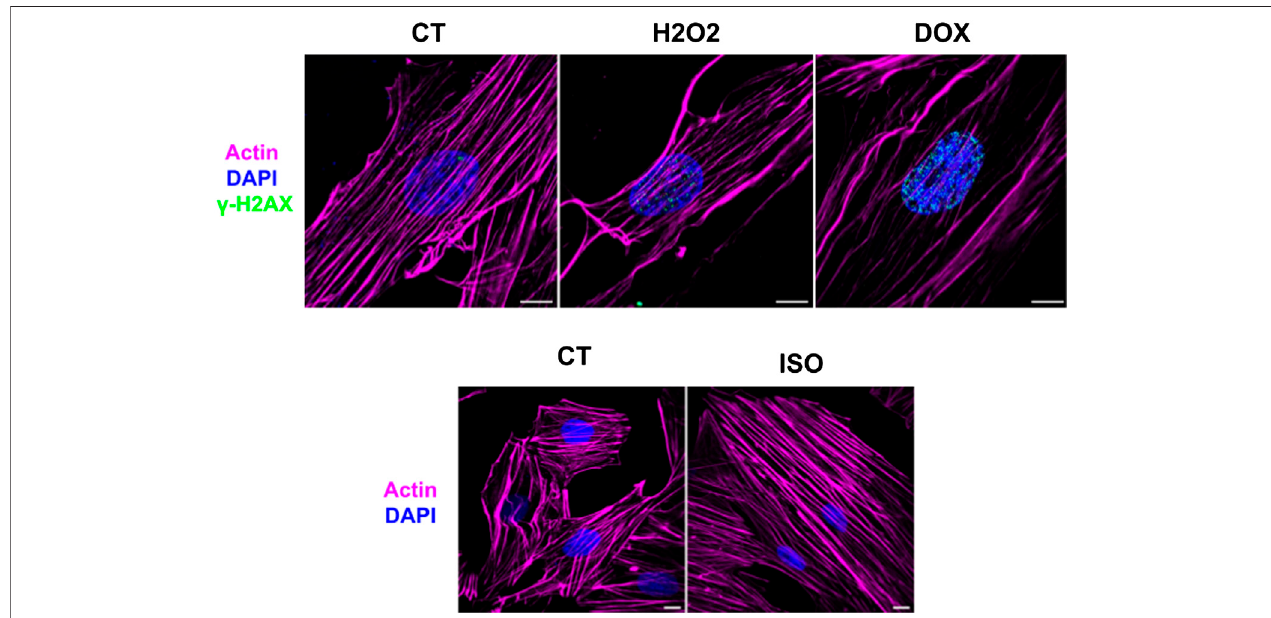
FIGURE1| Super-resolutionimagesfromcontrol(CT),H 2 O 2 doxorubicin(DOX)andisoproterenol(ISO)treatedH9c2cardiomyocytes.Theef fi cacyoftheoxidative stress resulting from H 2 O 2 and dox treatment was demonstrated by the increase of the γ -H2AX loci and the effect of isoproterenol was attested by the hypertrophy